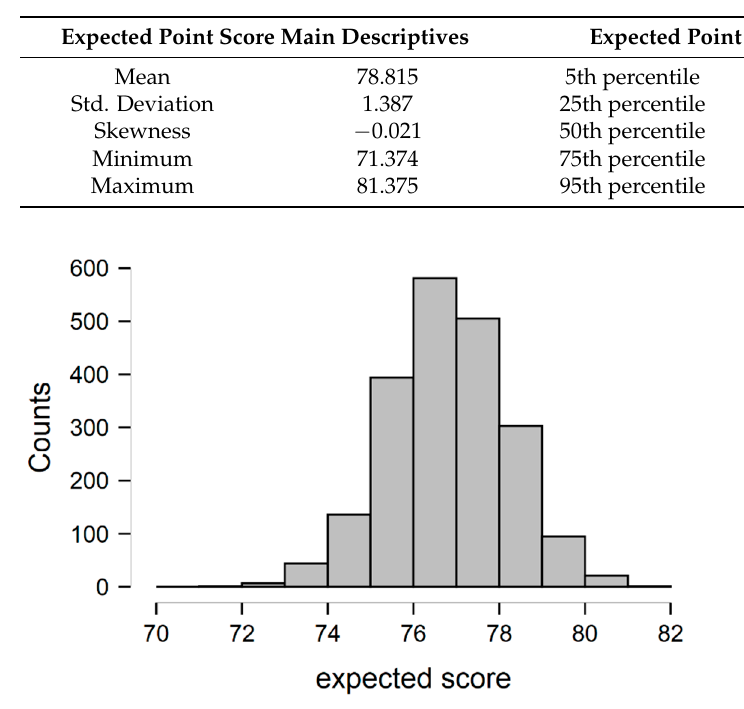
Figure 1. Question success rate histogram. Table 3. Expected point score. Table 3. Expected point score.